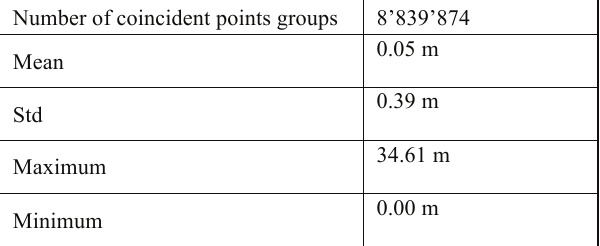
Table 3. Statistics of the differences between the maximum and minimum elevations of the groups of coincident points belonging to Piedmont DTM with horizontal resolution 5